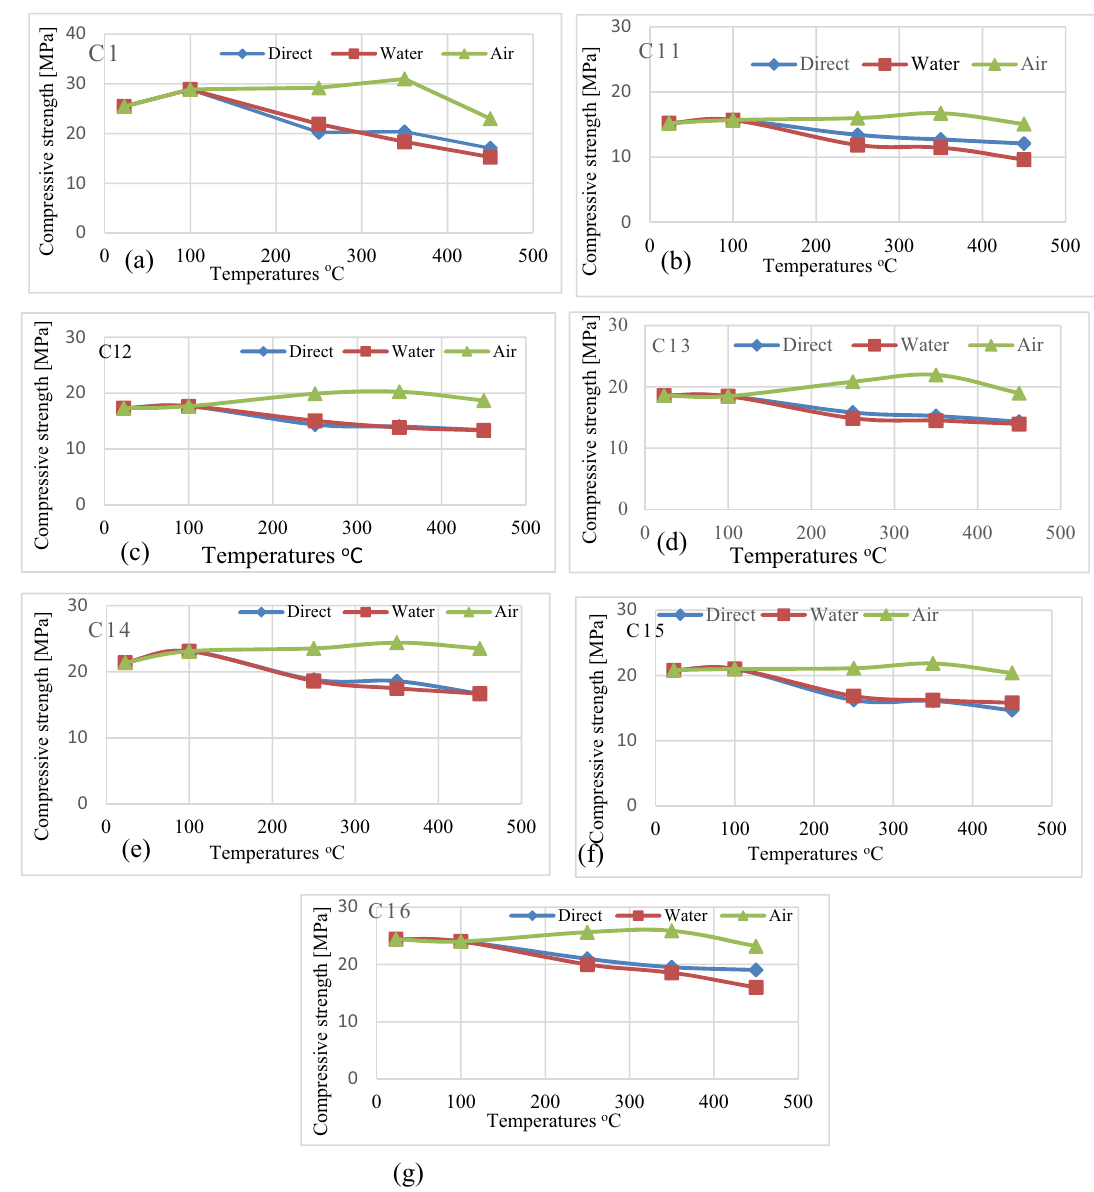
Figure 8: ( a – g ) Residual compressive strength of mixes with di ff erent temperatures.